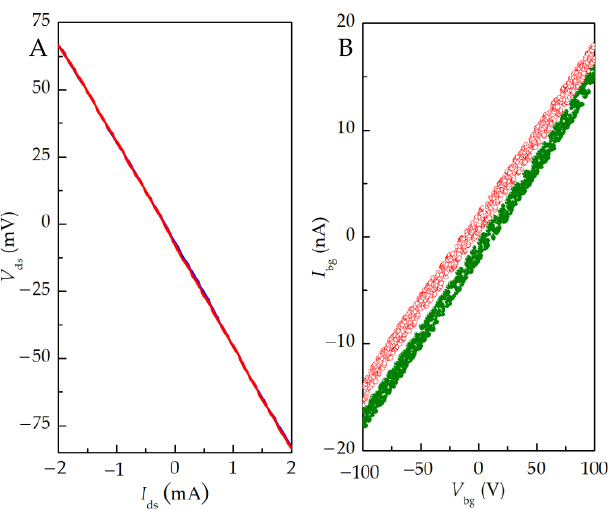
Figure 3. ( A ) I – V curve of device source – drain channel measured by four-probe method. The device source is connected to the source meter YOKOGAWA GS200 and a digital multimeter Agilent 34461A, and the back gate and drain are grounded. At room temperature, two points A – B on the outside of the source – drain channel are connected to a constant current source, and the voltage of two points a – b on the inside is measured. ( B ) Leakage characteristics of device back gate. The source – drain was grounded, the leakage current of the back gate electrode was measured with a Keithley 2410 at ~7.7 K. The red and green curves represent the leakage current obtained when the back gate voltage was scanned from −100 V to +100 V and +100 V to −100 V. The curves with different colors represent the data obtained by different scans, with good repeatability.